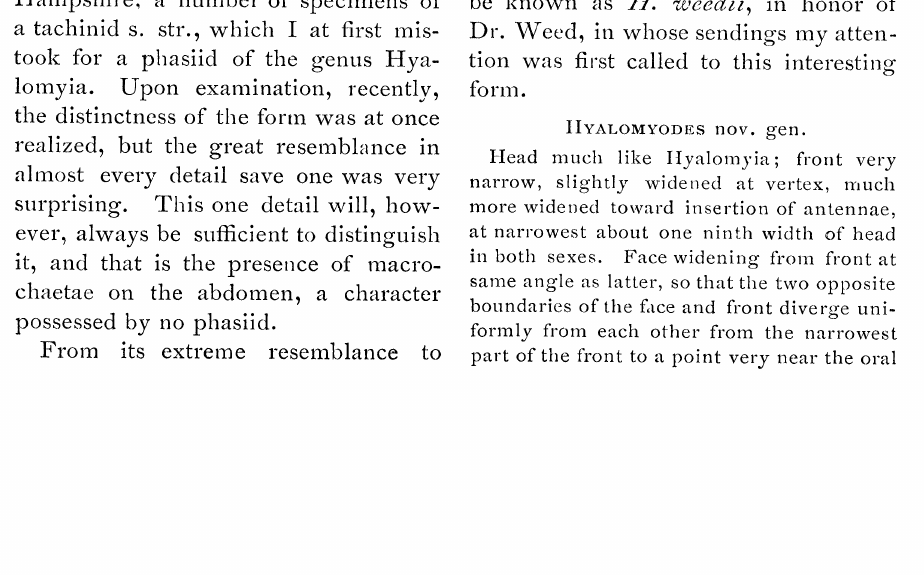
PLATE 14 Fig. .--Liobunum venlricosum kyemale. Immature. Natural size. 2.--Parts of same, Magnified. 2a.--Body. 2b.--Eye eminence. Side view. 2c.--Eye eminence. Front view. 2d.--Palpus, Side view. 2e.--Claw ofpalpus. Side view. PLATE Fig. I.--Liobunum politum magnum. Fe- male. Natural size. 2.Liobunum olilum. Parts of male, Magnified. 2a.Body. 2b.--Eye eminence. Side view. 2c.--Eye eminence. Front view. 2d.Palpus. Side view. 2e,--Claw of palpus. Side